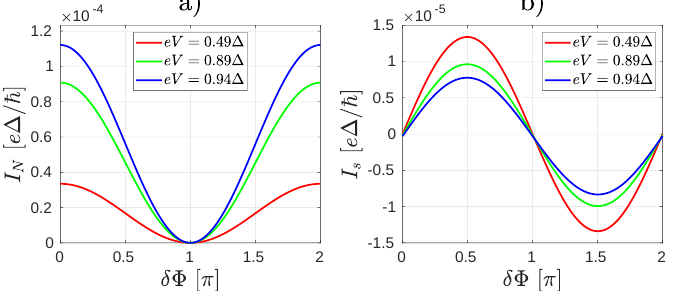
Figure 5. The currents I N ( a ) and I s ( b ) as a function of the phase difference δ Φ between the superconducting leads for the system depicted in Figure 1 for several bias voltage eV . ( a ) the Andreev current I N shows a minimum at δ Φ = π . ( b ) The current-phase dependence of supercurrent is I s ∝ sin δ Φ